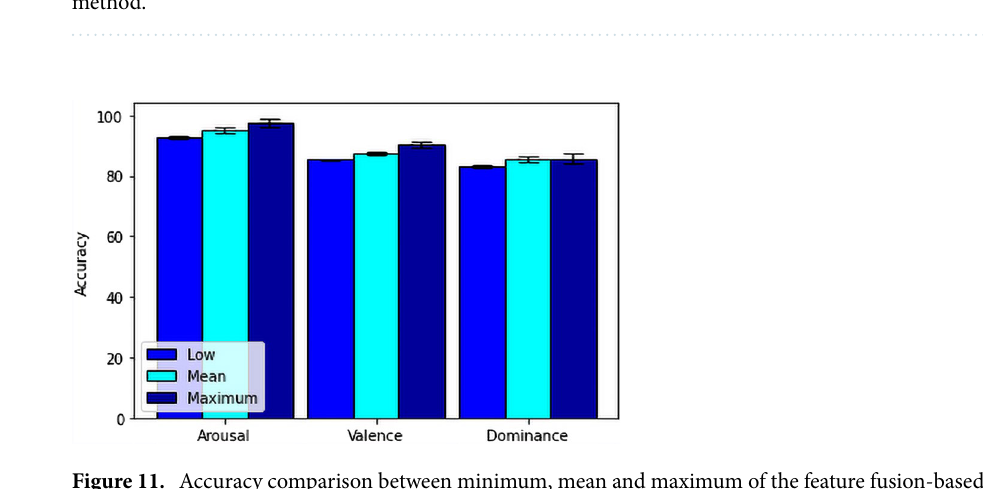
Figure 10. Accuracy comparison between minimum, mean and maximum of the feature fusion-based SVM method.